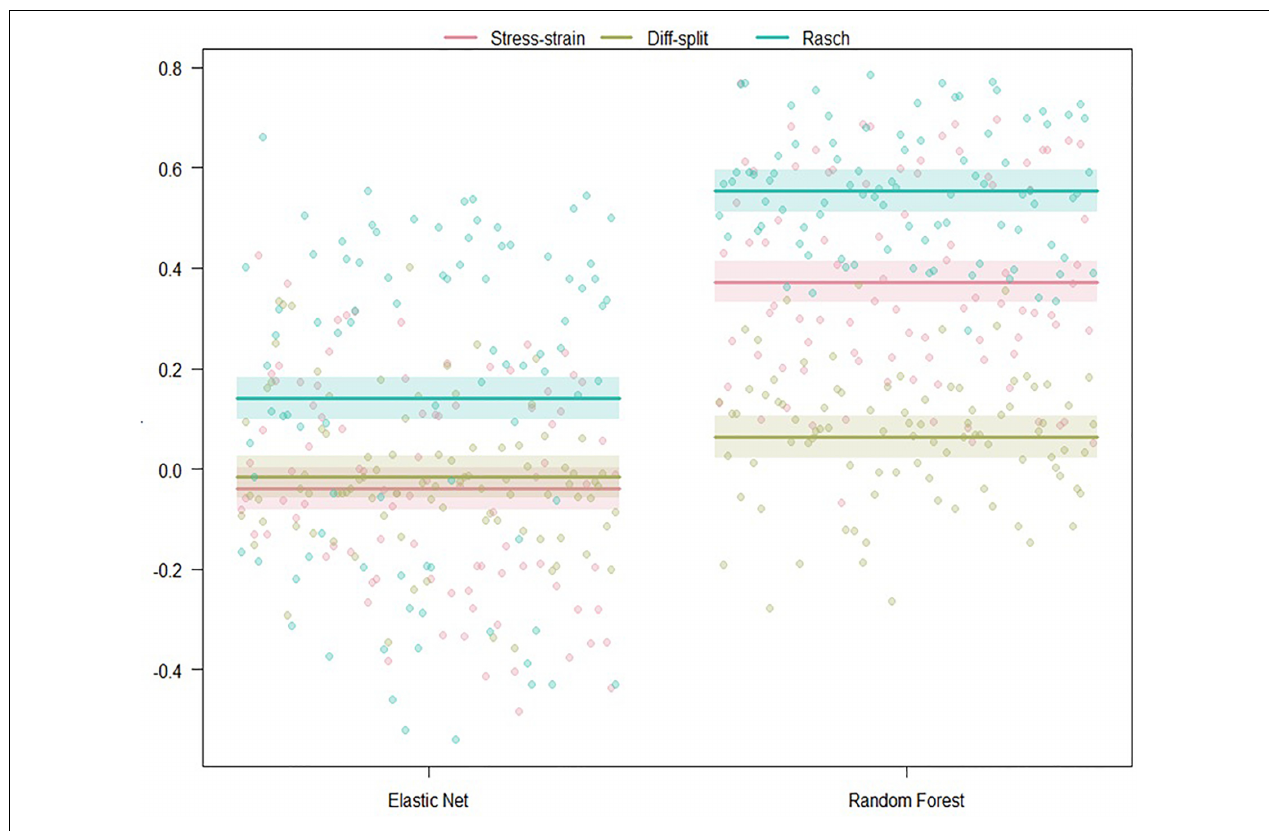
FIGURE 6 | Regression estimates for models trained on the ISR task and transferred to the WM task across labeling technique and machine learning algorithm. Points along the y -axis are GINI Index values for individual folds, lines are the regression estimate, and bars are the error of the estimate.